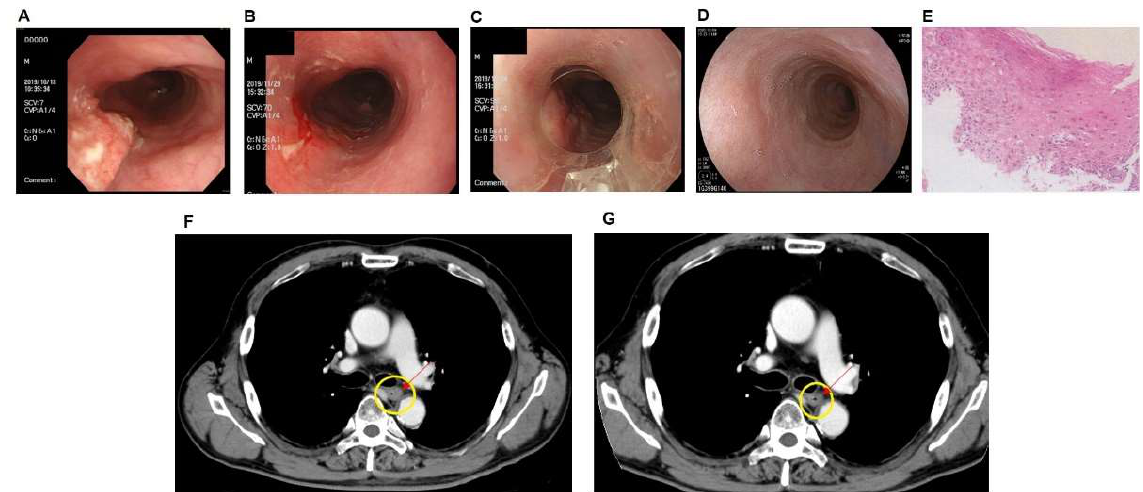
Figure 2. ( A ) Endoscopic images of middle intrathoracic esophagus carcinoma in the patient before treatment. An irregular elevation was found in the upper intrathoracic esophagus. ( B ) After radiation therapy, endoscopic images around the tumor lesion (66 Gy/33 times). ( C ) Endoscopic images after photodynamic therapy using ICG liposomes. The 635-nm and 810-nm lasers were applied to the periphery of the lesion via optical fiber for 20 min. ( D ) Endoscopic images after 1 year of treatment completion. Endoscopic disappearance was observed, and no recurrence was observed after over 1 year. ( E ) One year after the completion of treatment, the stratified squamous epithelium of the esophagus was thickened with parakeratosis in pathological section observation. No atypia was found; thus, no malignant finding was found in this biopsy. ( F ) CT image before photodynamic therapy. ( G ) CT image after photodynamic therapy.